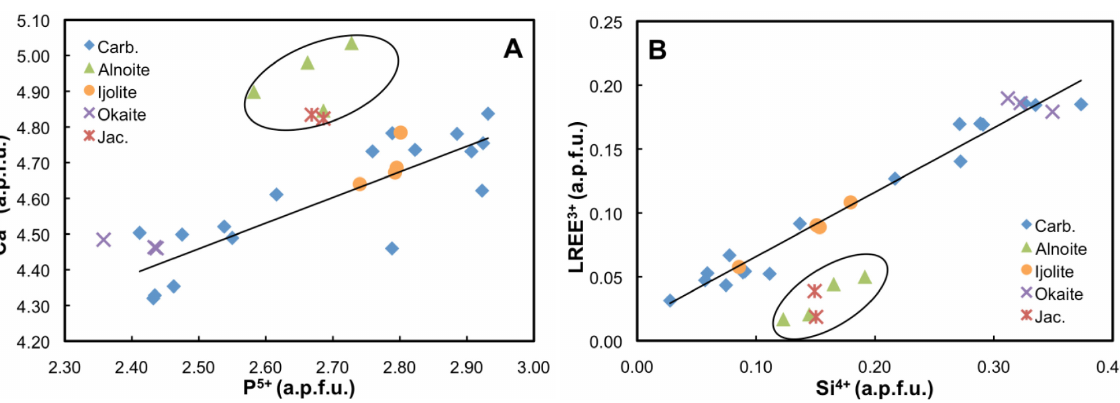
Figure 8. Chemical variation diagrams for apatite from different rock types (carbonatite (Carb.), alnöite, ijolite, okaite, and jacupirangite (Jac.)). ( A ) Ca 2+ vs. P 5+ ; ( B ) LREE 3+ vs. Si 4+ . Additional chemical compositions for apatite from carbonatite, okaite and melanite ijolite are from Chen and Simonetti